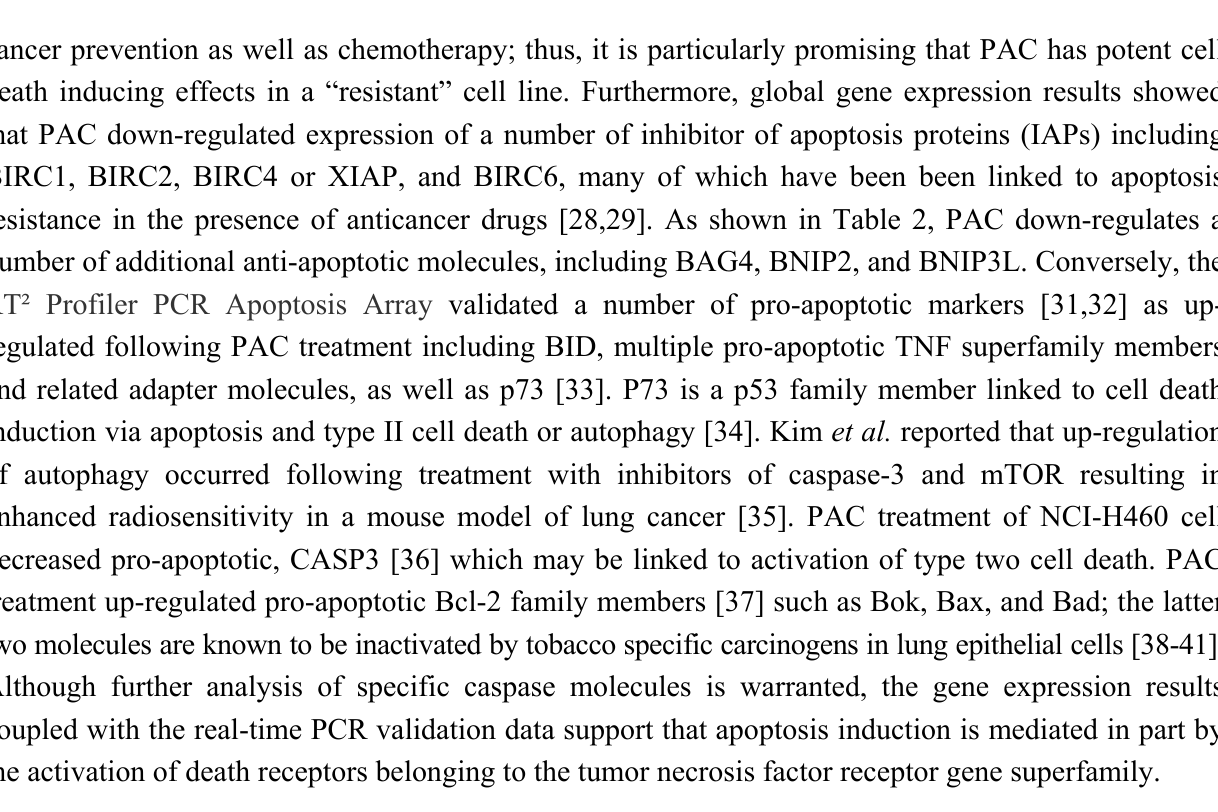
Table 2. Apoptotic associated genes validated by real-time PCR as up- or down-regulated in NCI-H460 cells following PAC